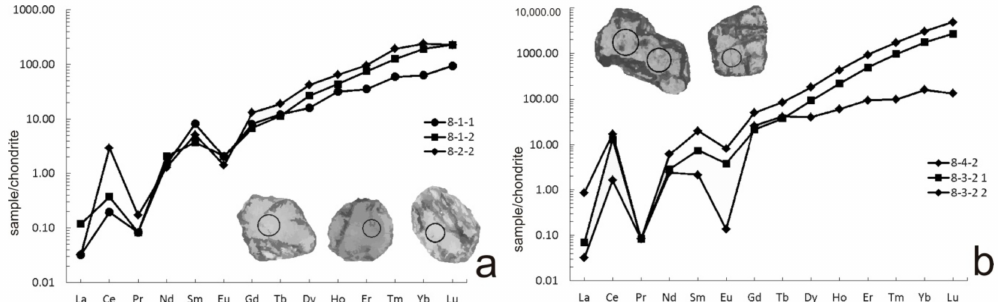
Figure 4. REE pattern in zircon crystals from metagabbro of the Kolvitsa massif (sample 200), normalized after Reference [33]. ( a ) Samples 8-1-1, 8-1-2 and 8-2-2; ( b ) Samples 8-3-2 and